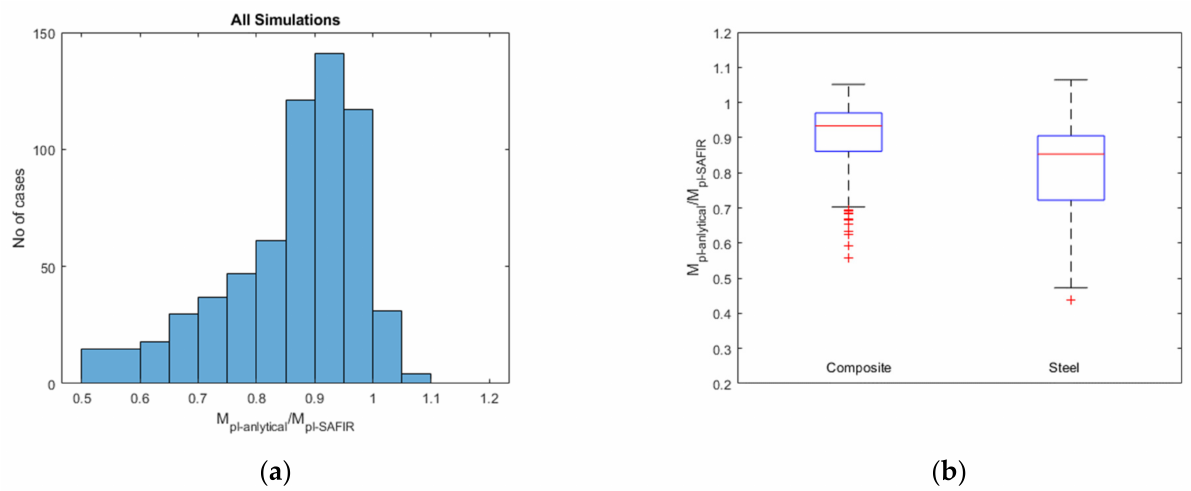
Figure 14. Assessment of the reliability level for all 680 configurations: ( a ) Gauss curve, ( b ) boxplot